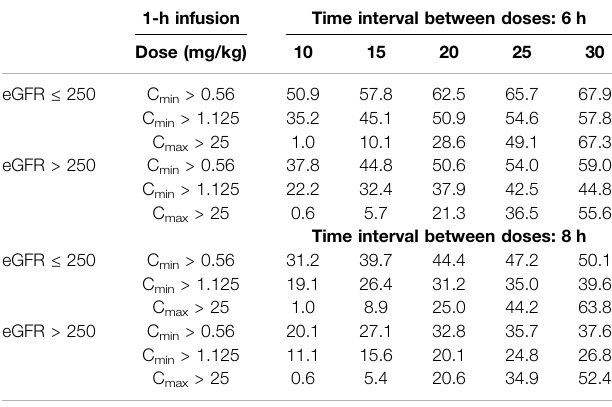
TABLE 6 | Results from simulated regimens consisting in ACV dose ranging from 10 up to 30 mg/kg infused in 1 h (standard regimen). The percentages of patients who achieved C min values > 0.56 and > 1.125 mg/L or C max values > 25 mg/L are showed according to an eGFR threshold of 250 ml/min/m 2 . Each regimen consisted of 1,000 simulated patients.